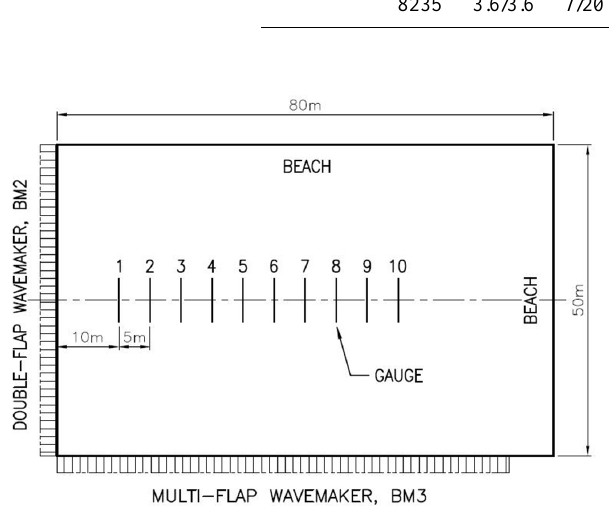
Figure 1. Sketch of the ocean basin facility and test equipment at